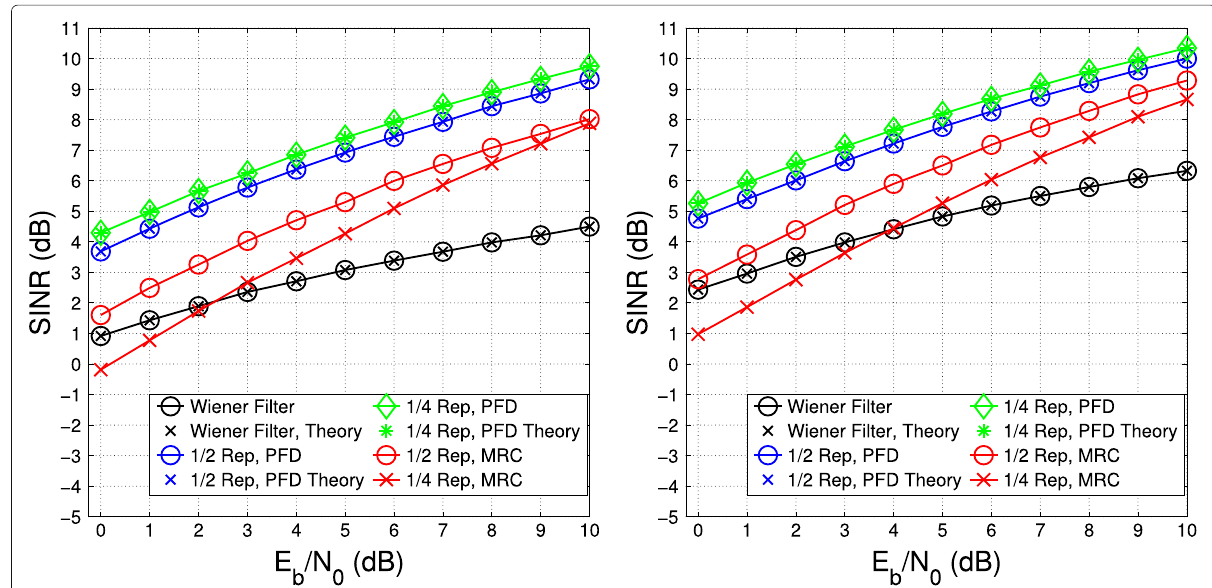
Fig. 7 The SINR plots comparing the performance of the Wiener filter (black), 1/2 Rate Repetition PFD (blue), 1/4 Rate Repetition PFD (green), and MRC (red). The abbreviation Rep. refers to symbol repetition. a Bandwidth overlap of 1/2. b Bandwidth overlap of